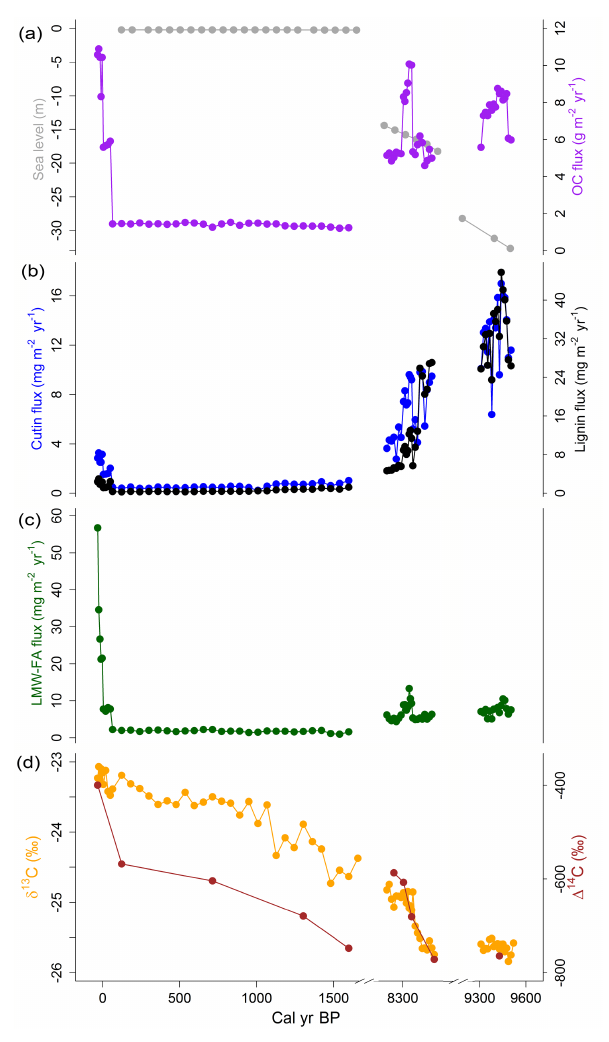
Figure 3. Organic matter composition of the sediment core GC58. The x axis has breaks due to gaps in the sediment chronology. (a) Organic carbon fluxes (gm − 2 yr − 1 ) were high at the bottom of the core. The high fluxes at the top of the core are likely related to the merging of two dating systems ( 210 Pb and 14 C; see Sect. 3.2). The sea level rose rapidly in the early Holocene (Lambeck et al., 2014). (b) Both lignin and cutin fluxes (mgm − 2 yr − 1 ) decrease to- ward the core top. High fluxes at the top of the core are influenced by the OC fluxes and likely do not show an actual increase in the fluxes of lignin and cutin (see Sect. 3.2). (c) Low molecular weight fatty acids (LMW-FA) show an influence of marine organic matter at the top of the core. (d) The δ 13 C (‰) values illustrate a gradual shift from terrestrial-dominated to more marine-dominated input of organic matter towards the core top. The (cid:49) 14 C (‰) values (cor- rected for the time between the deposition and the measurement) show that the bulk organic carbon is older at the bottom of the core than at the core top. The drop in the (cid:49) 14 C values ∼ 1700calyrs BP is likely an artefact caused by the age model used to correct for the (cid:49) 14 C